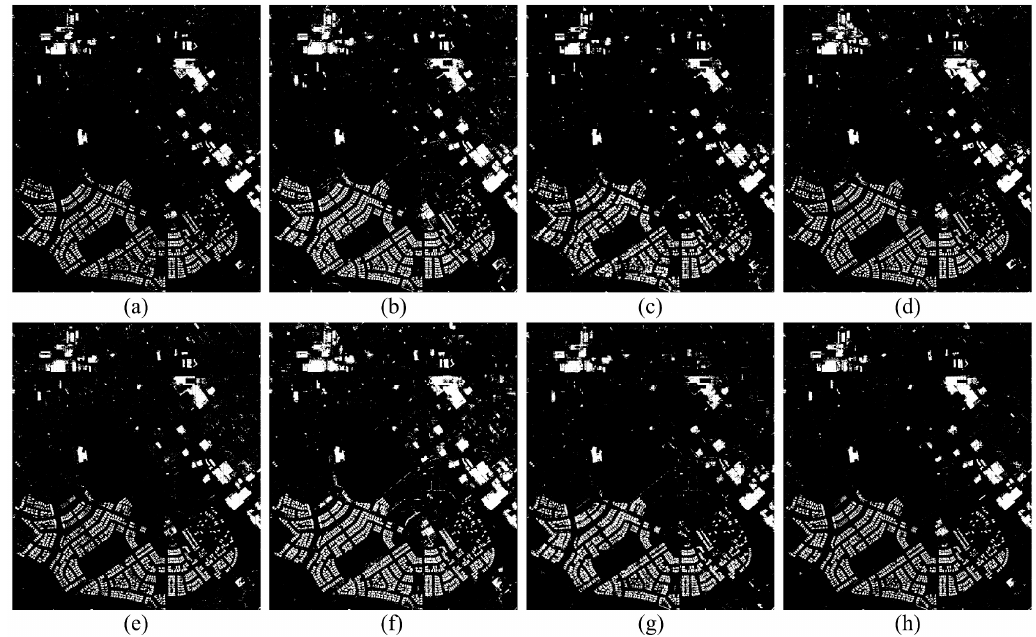
Figure 14. Binary change maps (Experiment 1) obtained by the ( a ) U-Net_Multi-feature, ( b ) SegNet_Multi-feature, ( c ) DeepLabv3+_Multi-feature, ( d ) squeeze-and-excitation W-Net_Multi-feature, ( e ) U-Net_only-image, ( f ) SegNet_only-image, ( g ) DeepLabv3+_only-image, and ( h ) squeeze-and-excitation W-Net_only-image.